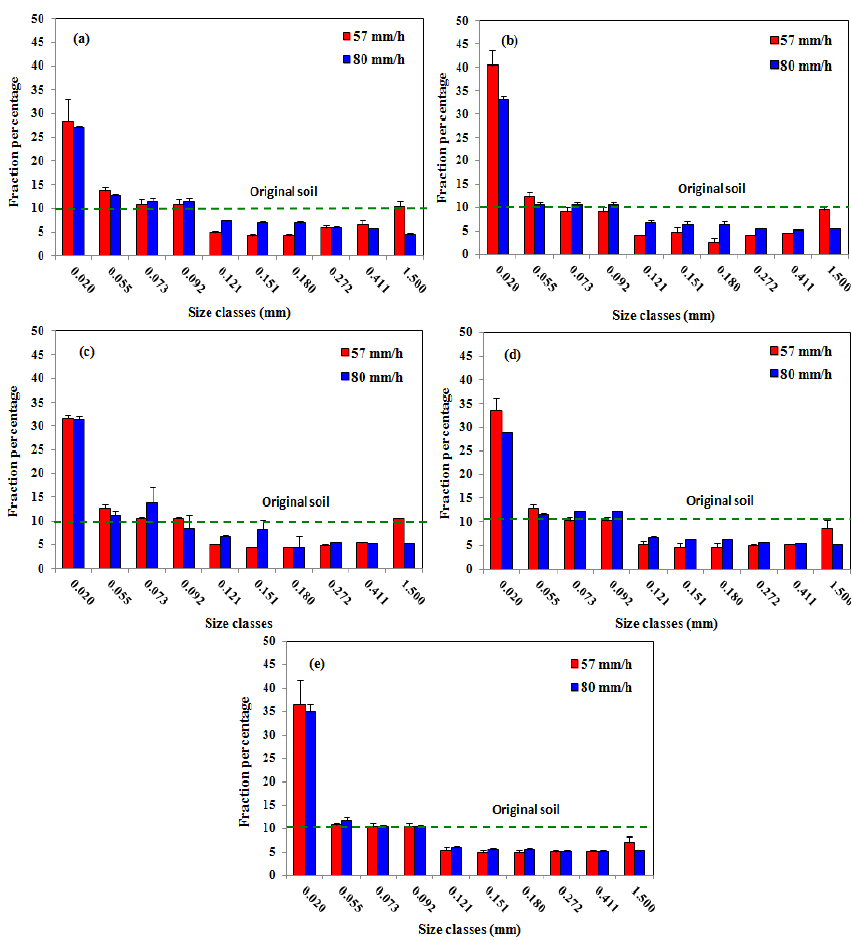
Figure 3. Comparison of particle size distribution in eroded soil D max 2mm compared to the original soil for different slopes of (a) 0.5, (b) 2.5, (c) 5, (d) 10 and (e) 20%. Error bars represent standard errors of the